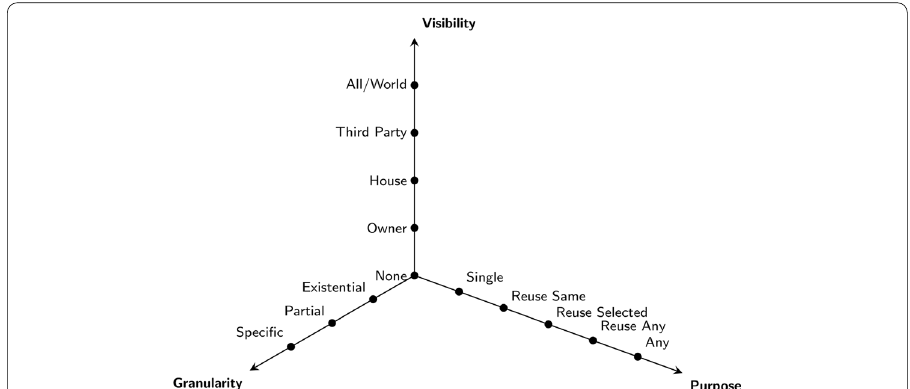
Fig. 5 Privacy dimensions as suggested by Barker et al. (2009): The three axis depict the dimensions and their possible values. The Retention dimension is not shown ( Retention ∈ { date, ∞}